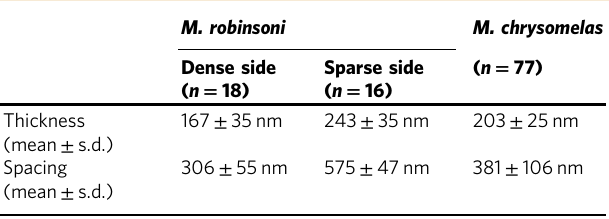
Table 1 The thickness and spacing measured from TEM micrographs (Fig. 2i, j) M. robinsoni M. chrysomelas Dense side Sparse side ( n = 77) ( n = 18) ( n = 16) Thickness 167 ± 35 nm 243 ± 35 nm 203 ± 25 nm (mean ± s.d.) Spacing 381 ± 106 nm (mean ± s.d.) s.d. = standard deviation from the designated number of measurements ( n